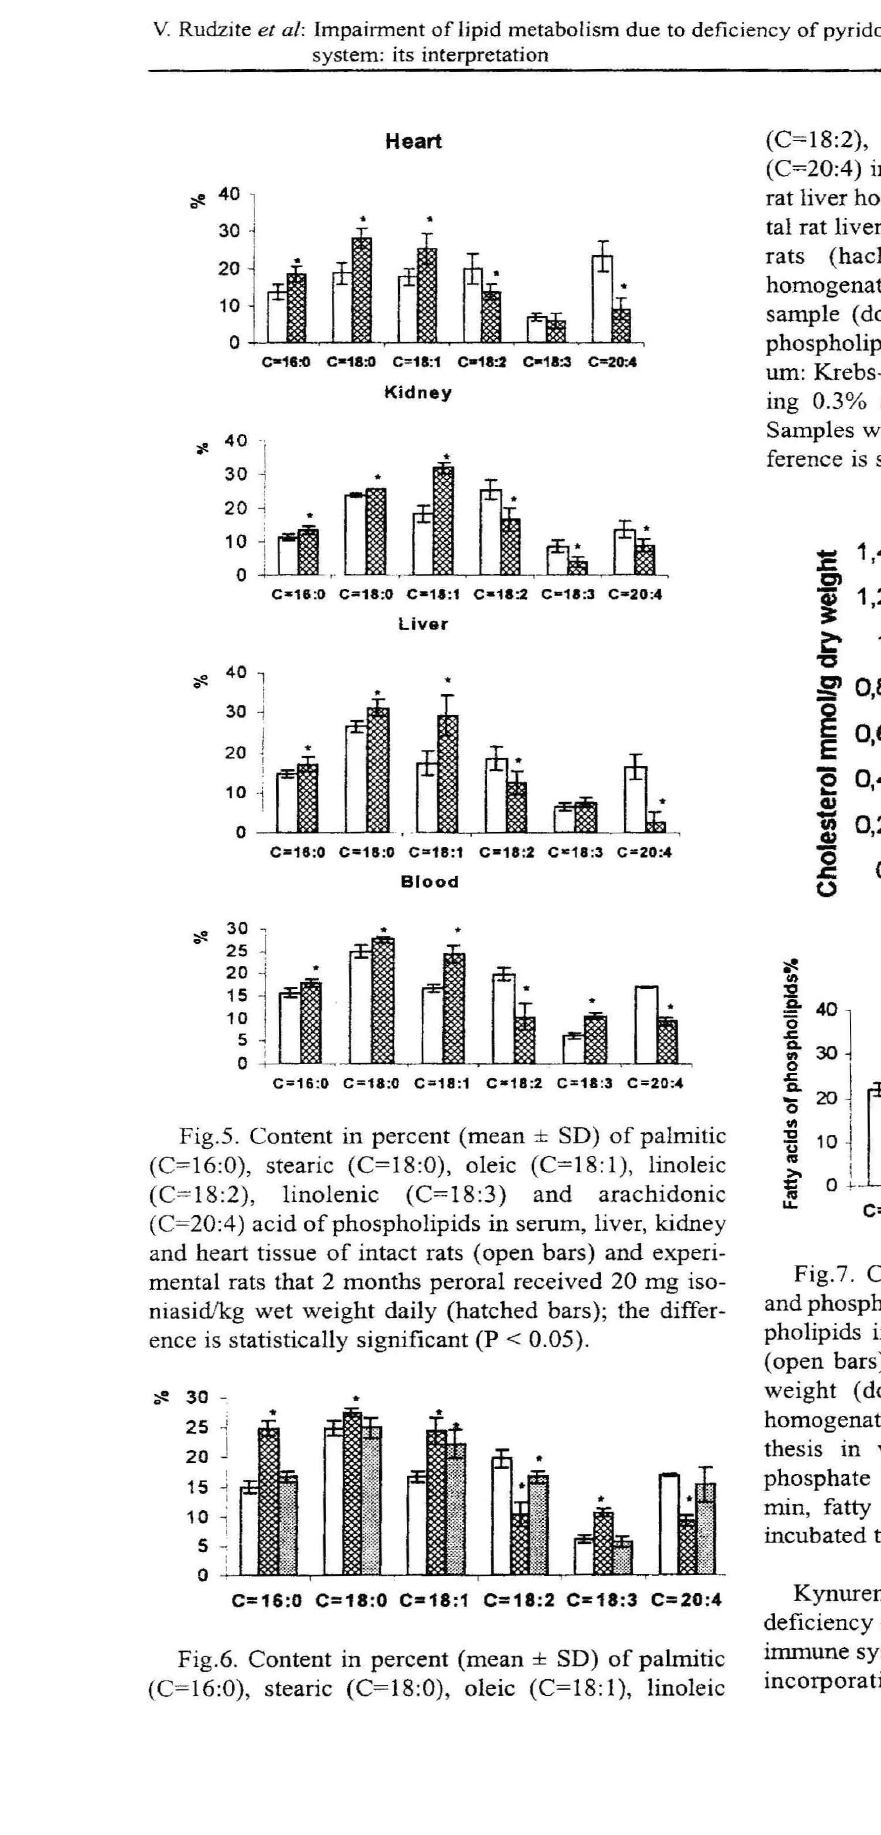
Fig.6. Content in percent (mean ± SD) of palmitic